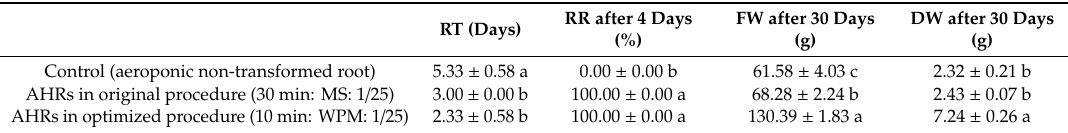
RR after 4 Days FW after 30 Days DW after 30 Days RT (Days) (%) (g) (g)